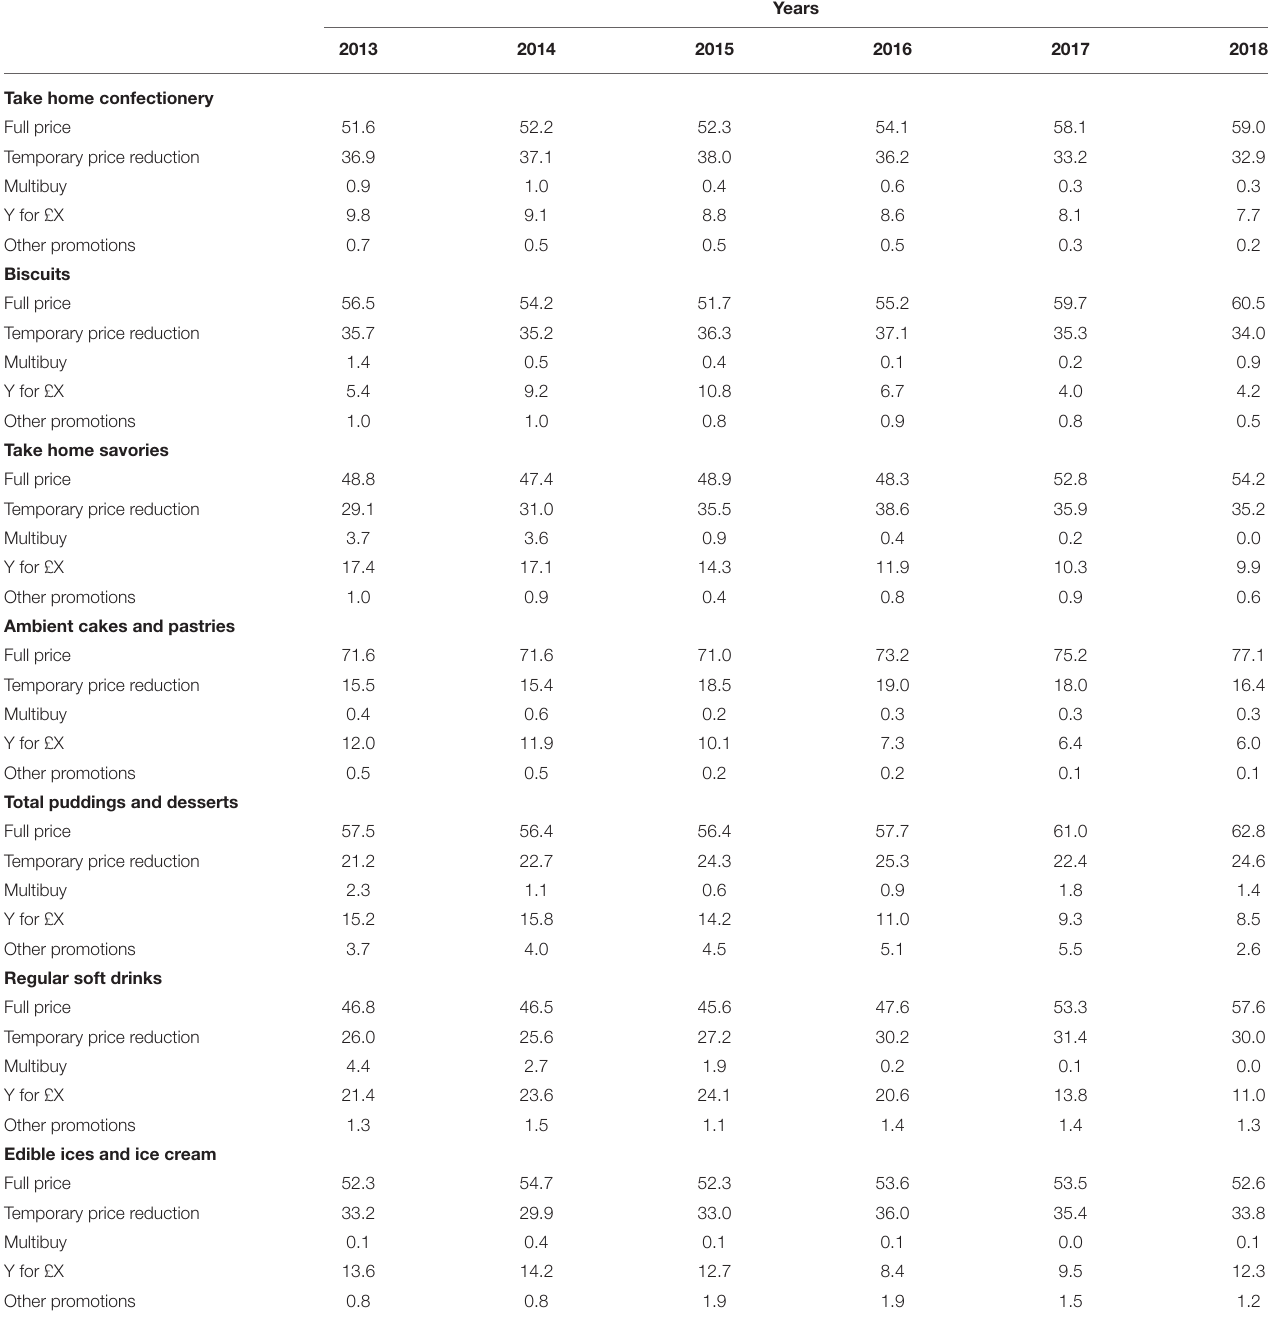
TABLE 2 | Share of sales at full price and promotion by discretionary